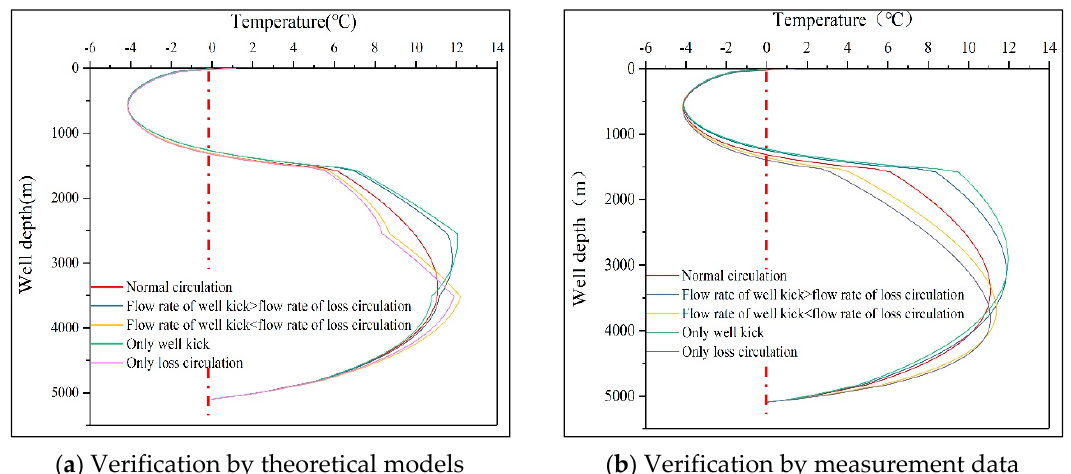
Figure 9. The temperature di ff erence between in annulus and inside drill string when multi-pressure system, only leakage or only overflow occurs; ( a , b ) show conditions when the multi-pressure system is located in middle formation and at bottom hole,